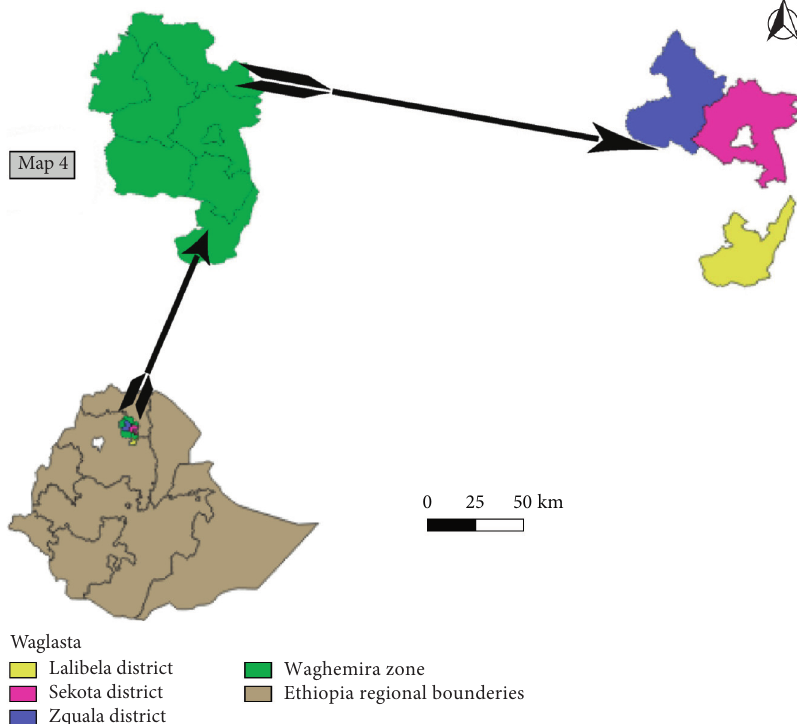
Figure 1: Map of study